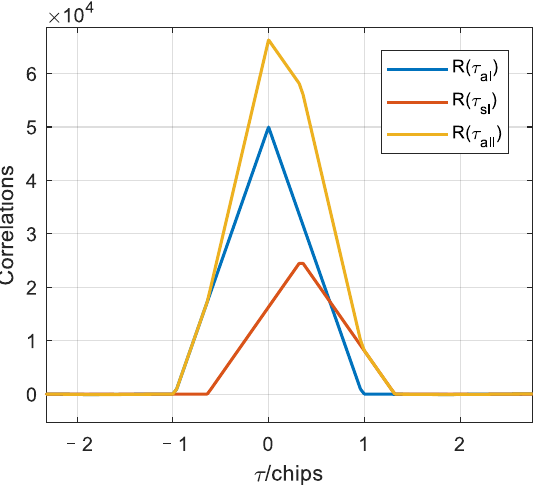
Figure 2. Demonstration of correlation peak distortion of conventional traction